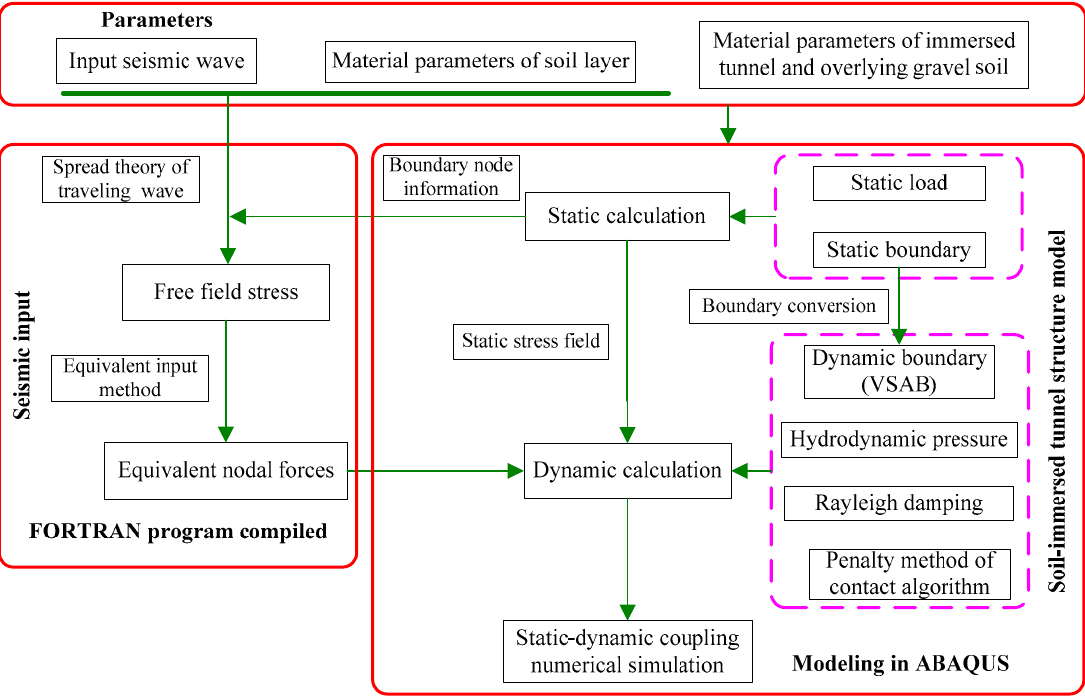
Figure 11. Flowchart of numerical simulation process.